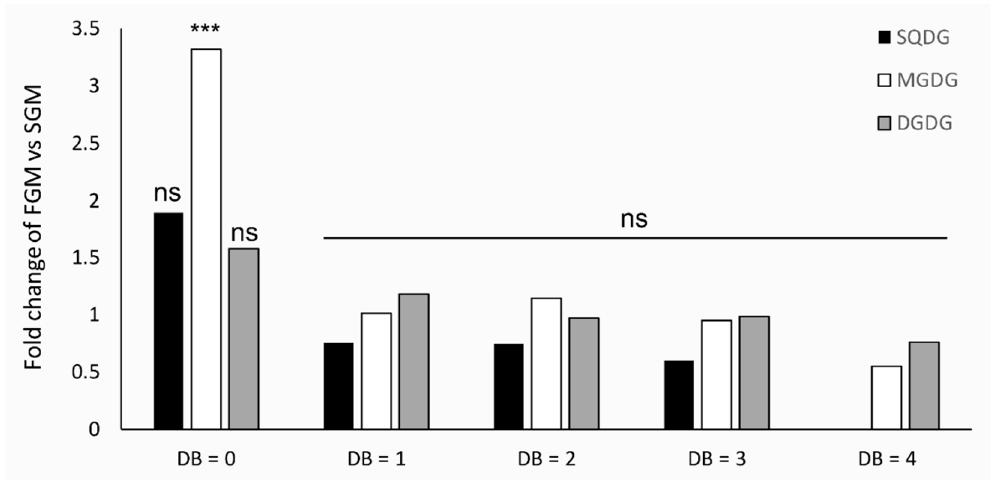
Figure 6. Comparison of the lipid unsaturation levels in Synechocystis sp. PCC 6803 tolC -mutant strain lipidomes obtained from cells cultivated in FGM or in SGM. For each lipid class, the indicated fold-changes were calculated based on the sum of peak areas of lipid species with particular level of unsaturation in FGM versus those in SGM. Data were normalized by the fold change of the total lipid content of each lipid class. *** p < 0.005; ns: not statistically significant difference.